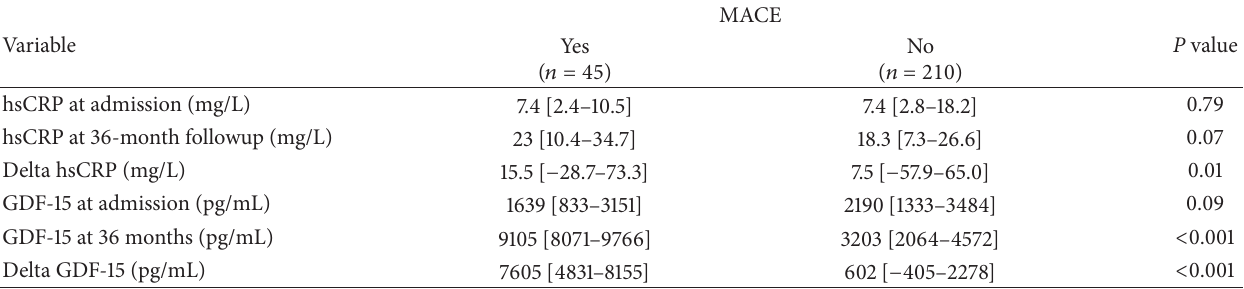
Table 2: Inflammatory markers of non-ST-segment elevation acute coronary syndrome patients with and without MACE at 36-month